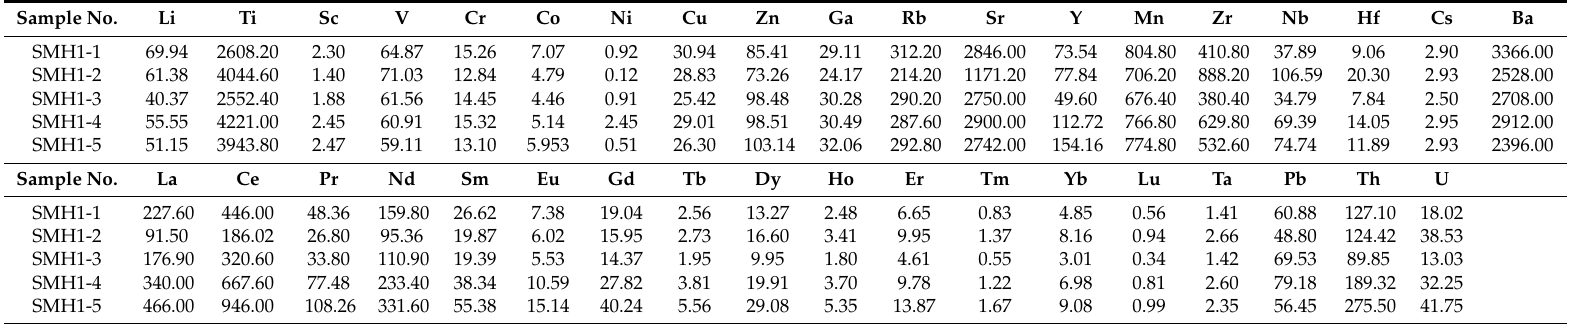
Table 3. Whole-rock trace and rare-earth elements (ppm) of syenites in the Saima